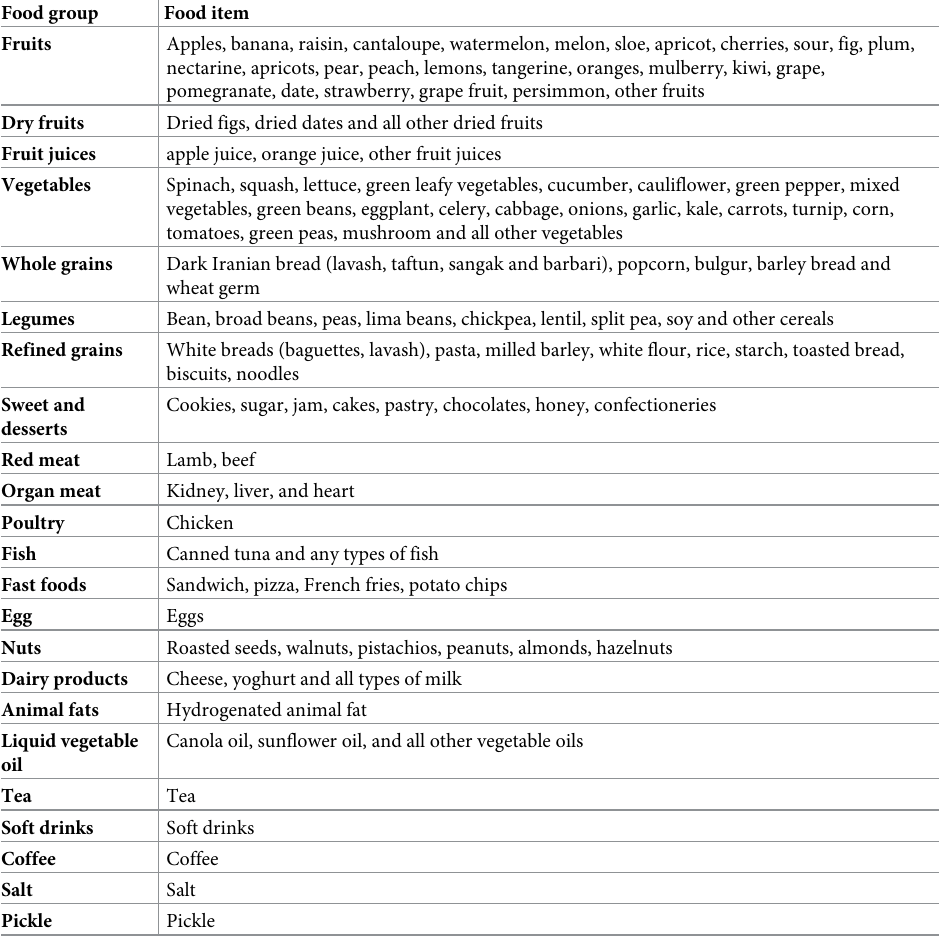
Table 1. Components food groups used in dietary pattern